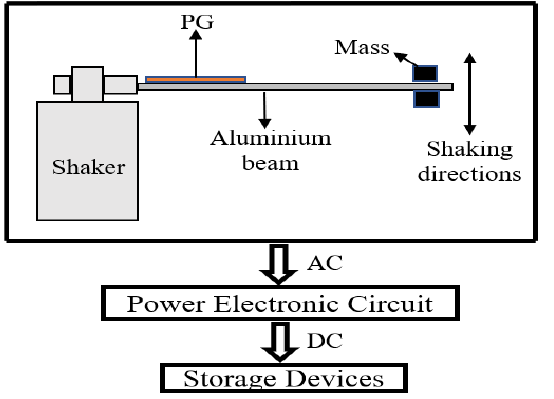
Figure 1. A flow chart representing the PEH systems.